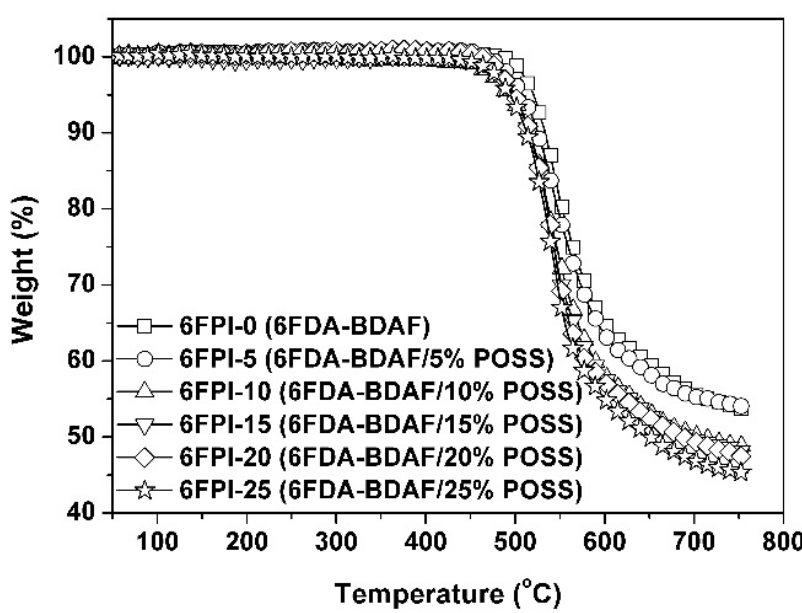
Figure 11. TGA curves 6FPI/POSS composite films under nitrogen flow. The DSC diagram of PI films was shown in Figure 12. It can be seen from the figure that the incorporation of TSP-POSS has little effect on the T g values of PI films. The T g value of the pristine 6FPI-0 film was very close to those of the PI composite films. On one hand, the TSP-POSS possessed bulky molecular chains, which were not easy to move at elevated temperatures. On the other hand, the TSP-POSS additives might not have a strong interaction with the PI matrix due to the absence of active groups in the PI matrix. These factors lead to that TSP-POSS additives have little effect on the glass transition behaviors of the PI composite films.